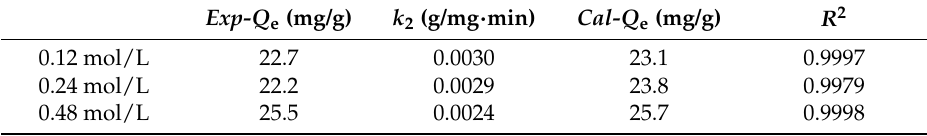
Table 3. Comparison between the measured and estimated Q e from the pseudo-second-order